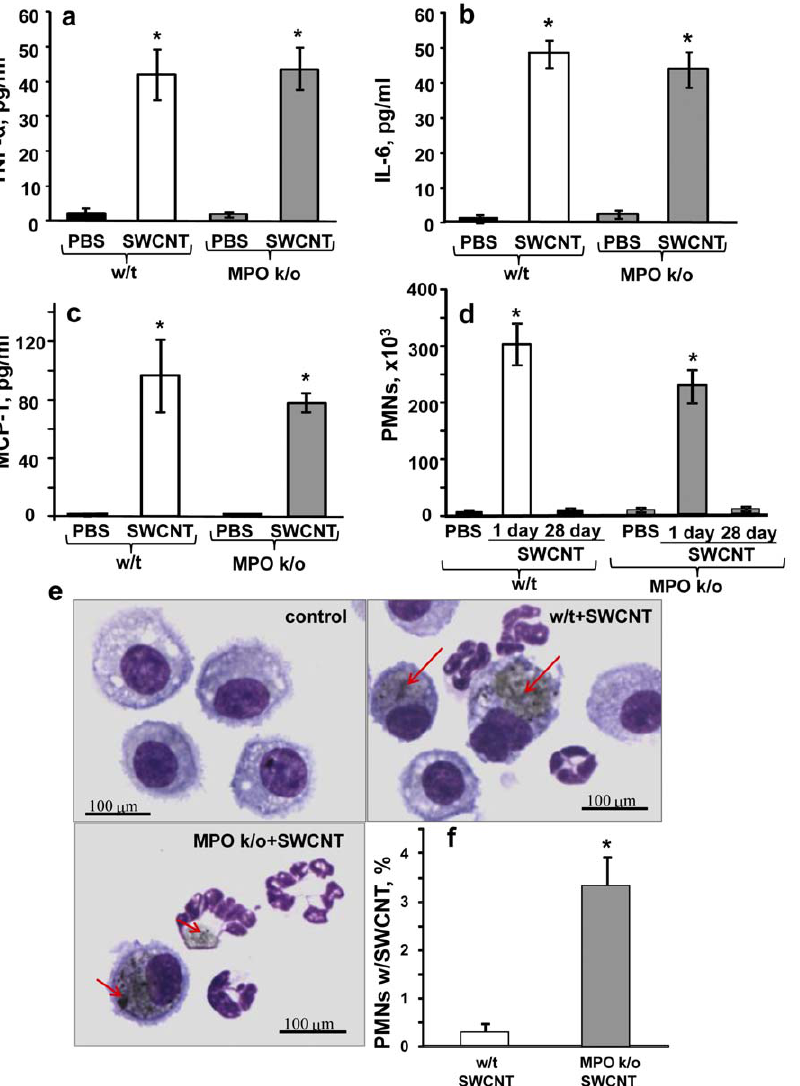
Figure 1. Characterization of pulmonary inflammatory responses to SWCNT in w/t and MPO k/o mice at day 1 after pharyngeal aspiration exposure. a–c. Levels of pro-inflammatory cytokines (a - TNF- a ; b - IL-6; c – MCP-1) in BAL fluid of w/t and MPO k/o mice. Mean 6 SEM (n=6 mice/group). *p , 0.05, vs control PBS-exposed mice. d. Content of PMNs in BAL fluid of w/t and MPO k/o mice. Mean 6 SEM (n=6 mice/group). *p , 0.05, vs control PBS-exposed mice. e. Typical microscopic images of inflammatory cells in BAL fluid with SWCNT inclusions (red arrows). f. Content of PMNs with engulfed SWCNT in BAL fluid of w/t and MPO k/o mice. Mean 6 SEM (n=6 mice/group). *p , 0.05, vs w/t mice.